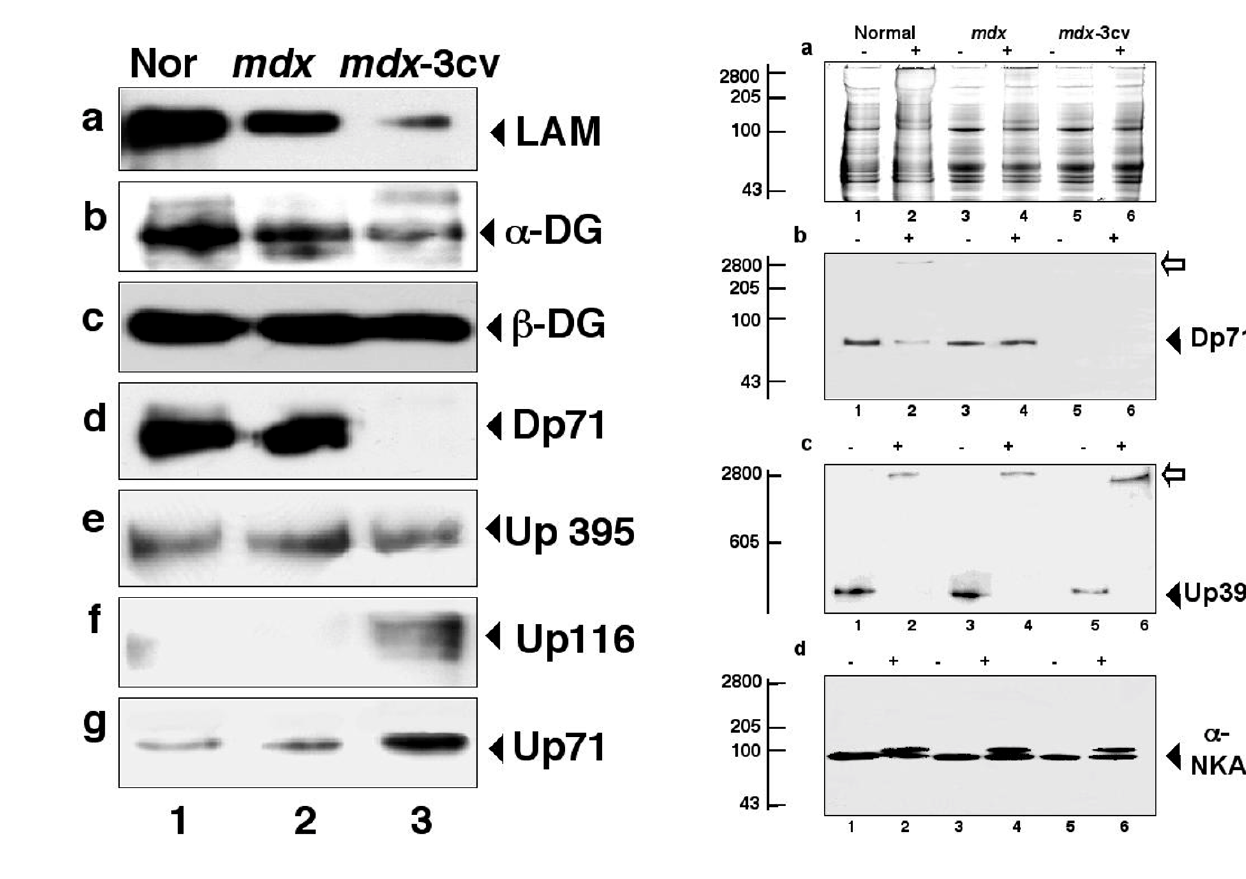
Figure 7 Immunoblot analysis of β dystroglycan and associ- ated components in normal and dystrophic brain- membranes. Shown are identical immunoblots labeled with antibodies to laminin (LAM) (a), α -dystroglycan ( α -DG) (b), β -dystroglycan ( β -DG) (c), dystrophin of apparent 71 kDa (Dp71) (d), full-length utrophin of apparent 395 kDa (Up395) (e), the utrophin isoform of apparent 116 kDa (Up116) (f), and the utrophin isoform of apparent 71 kDa (Up71) (g). Lanes 1 to 3 represent microsomal membranes isolated from normal brain, mdx brain, and mdx -3cv brain, respectively. The position of immuno-decorated protein bands is indicated by arrow heads.